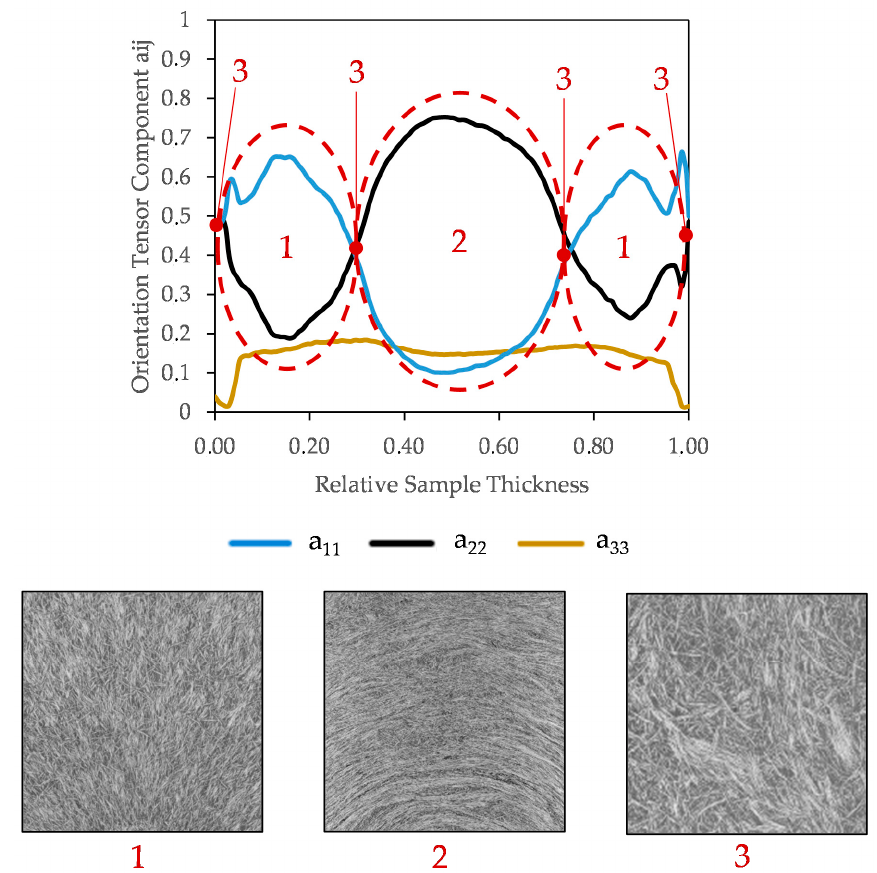
Figure 21. Orientation tensor components ( a 11 , a 22 , a 33 ) over relative sample thickness for a nominal fiber content of 60 wt.% (Bluestone tool; segment B), with characteristic zones after Osswald and Menges [36] (shell layers = 1, core layer = 2, transition layers / skin layers =